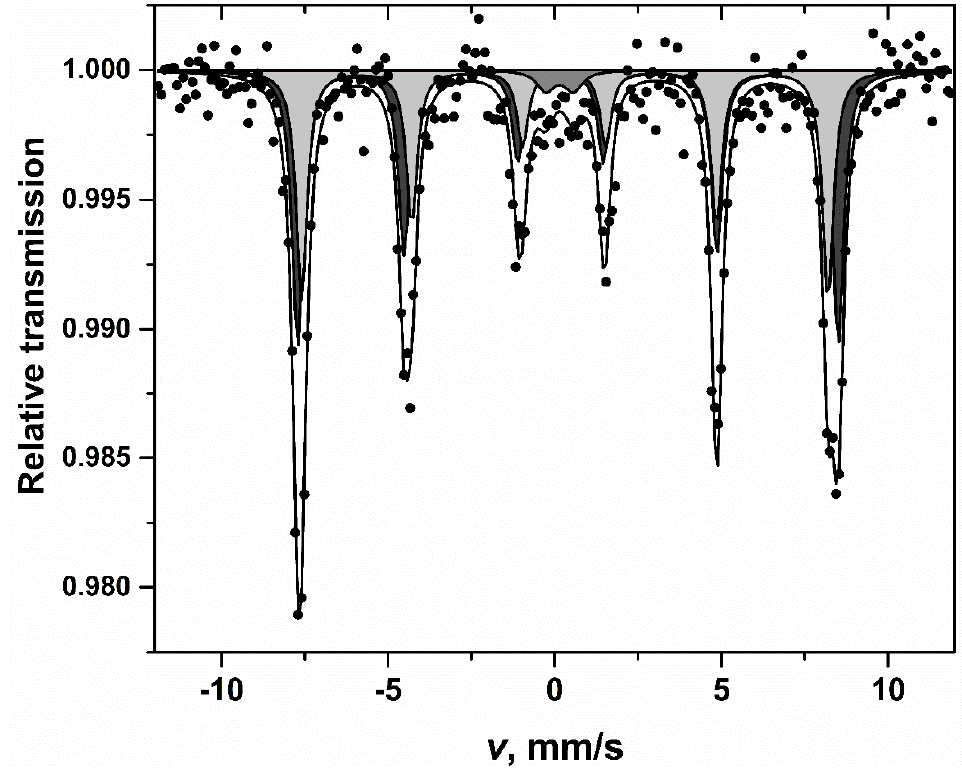
Figure 5. Mössbauer spectrum of BFO powders recorded at room temperature.